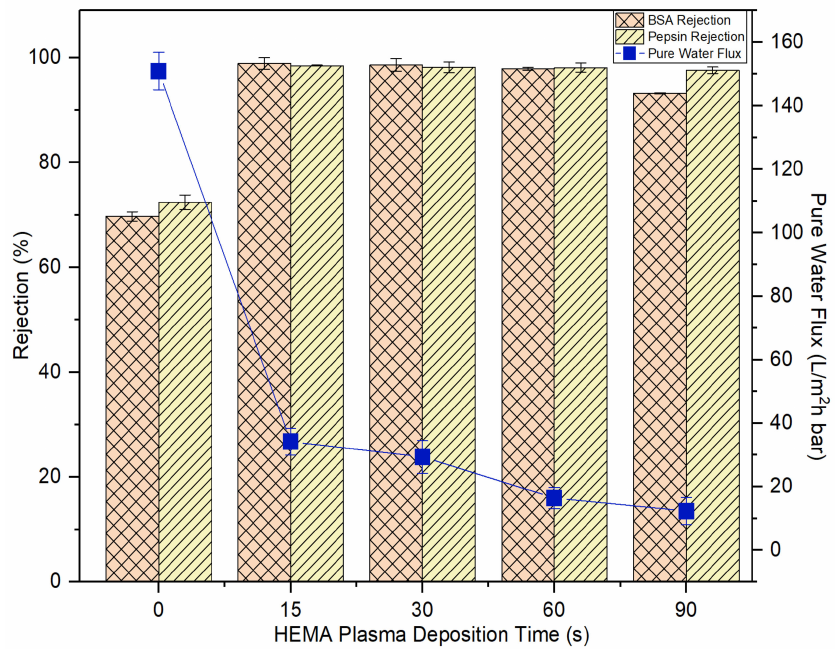
Figure 10. The impact of plasma deposition time of HEMA on the membrane pure water flux and solute rejection using 2000 mg / L BSA solution and 2000 mg / L pepsin solution. Error bars indicate standard